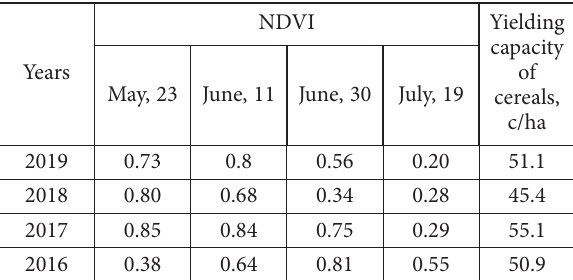
Table 1. Output data for constructing a system of normal equations on the example of model land use NDVI Yielding Years